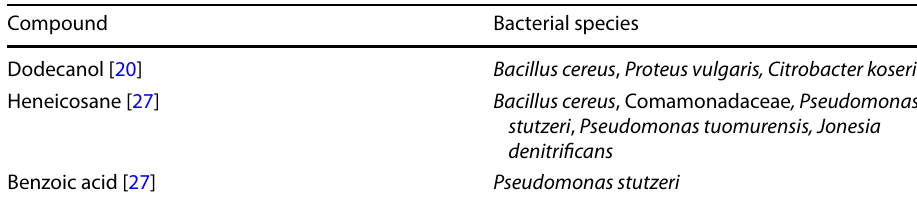
Table 4 List of specific products associated with the biodegradation of